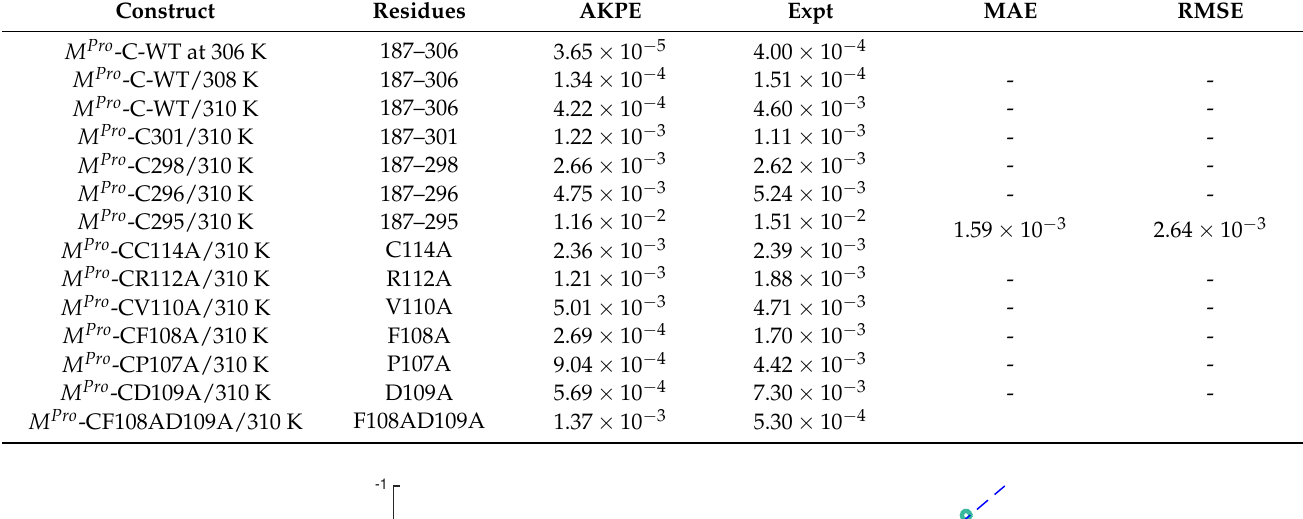
Table 5. Comparison of the kinetic constants calculated from AKPE and experiments.